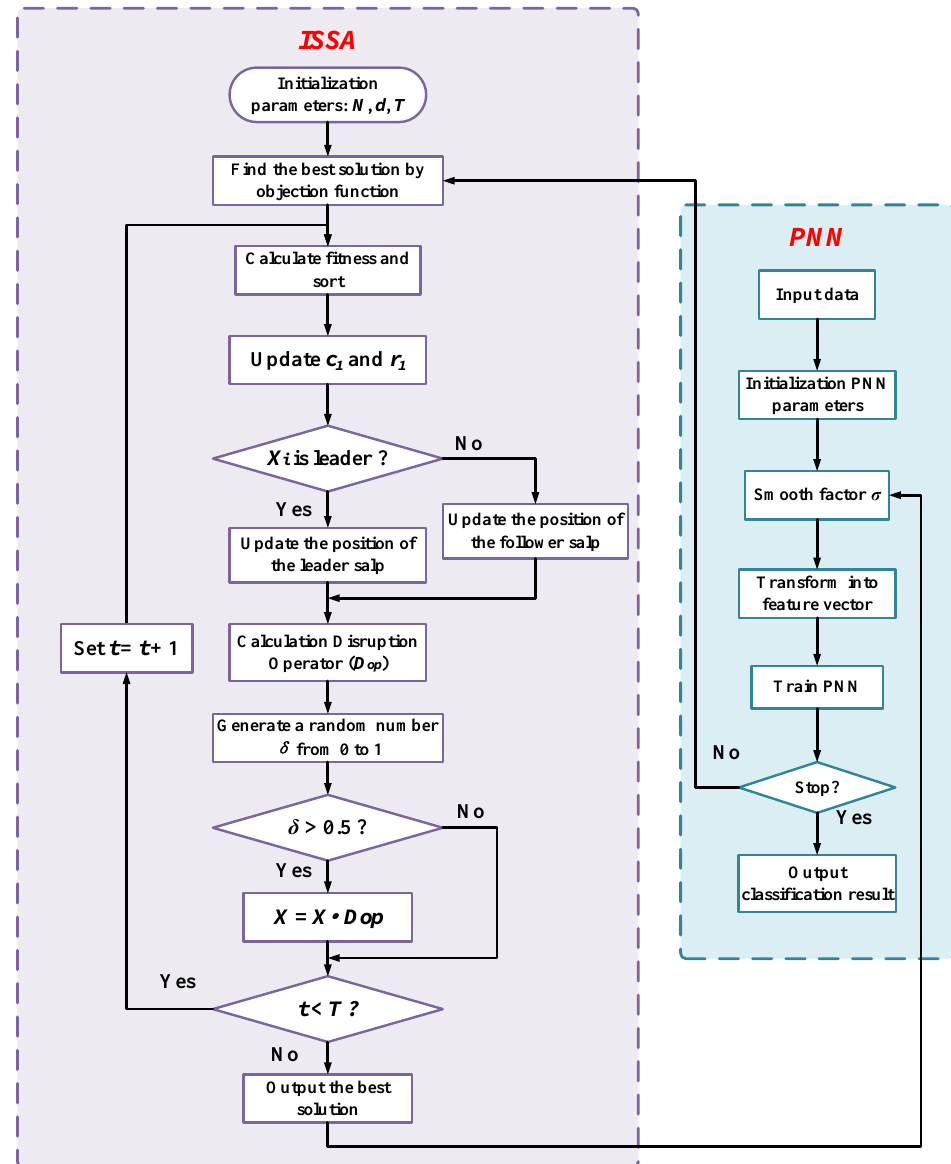
Figure 2. The diagram of the proposed ISSA-based PNN for fault